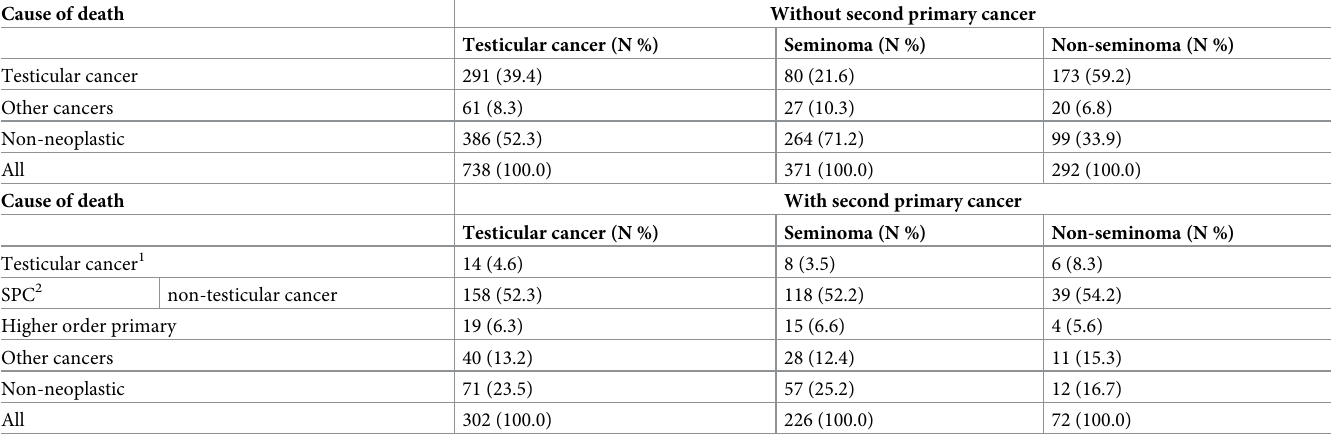
Table 5. Cause of death in testicular cancer with or without second primary